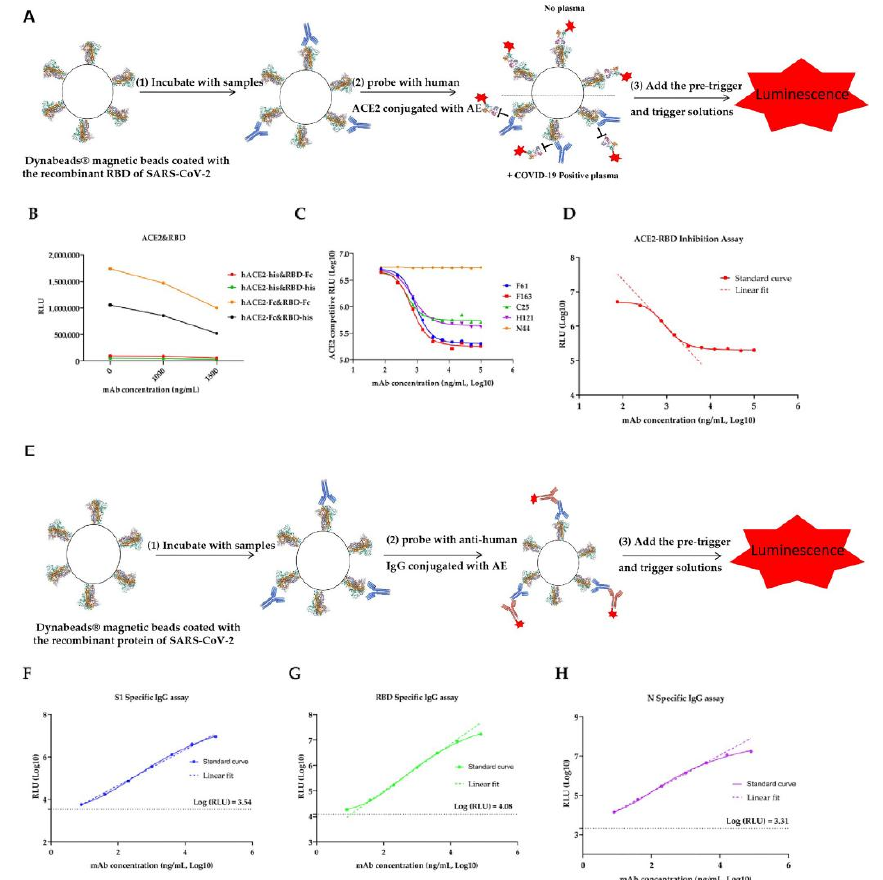
Figure 1. The methods of ACE2-RBD-inhibiting Ab and SARS-CoV-2 specific IgG test construction. ( A ) Graphic representation of ACE2-RBD inhibition assay. ( B ) Optimization of the antigen using in ACE2-RBD inhibition assay. ( C ) Selection of antibody standards from F61, F163, H121, C25, N44 for ACE2-RBD inhibition assay. ( D ) Standard curve for ACE2-RBD-inhibiting mAb F163. Linear range of standard curve were determined using linear regression curves: Y = − 1.364X + 10.08, R2 = 1.0000. ( E ) Graphic representation of anti-SARS-CoV-2 IgG detection using S1 segment of spike protein, receptor binding domain (RBD) and nucleoprotein. ( F – H ) Standard curve for S1-IgG, RBD-IgG, and N-IgG, mAb F163 was used as standards for S1-IgG and RBD-IgG detection, mAb N44 was used as standards for N-IgG. Linear range of standard curve were determined using linear regression curves: Y = 0.8393 + 2.983, R2 = 0.9939 for S1-IgG; Y = 0.9263X + 3.139, R2 = 0.9998 for RBD-IgG; Y = 0.9423X + 3.268, R2 = 0.9998 for N-IgG, respectively. The background RLU of the anti-human IgG-AE alone on the S1, RBD and N labeled beads were displayed as a dotted line parallel to the x axis.